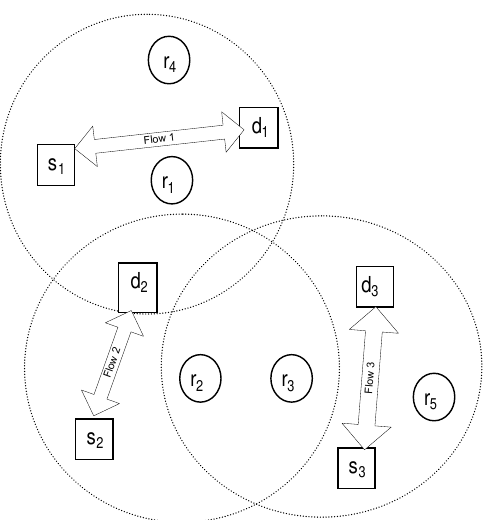
Figure 7. Ad hoc network environment where relay node may cause interference. From work in